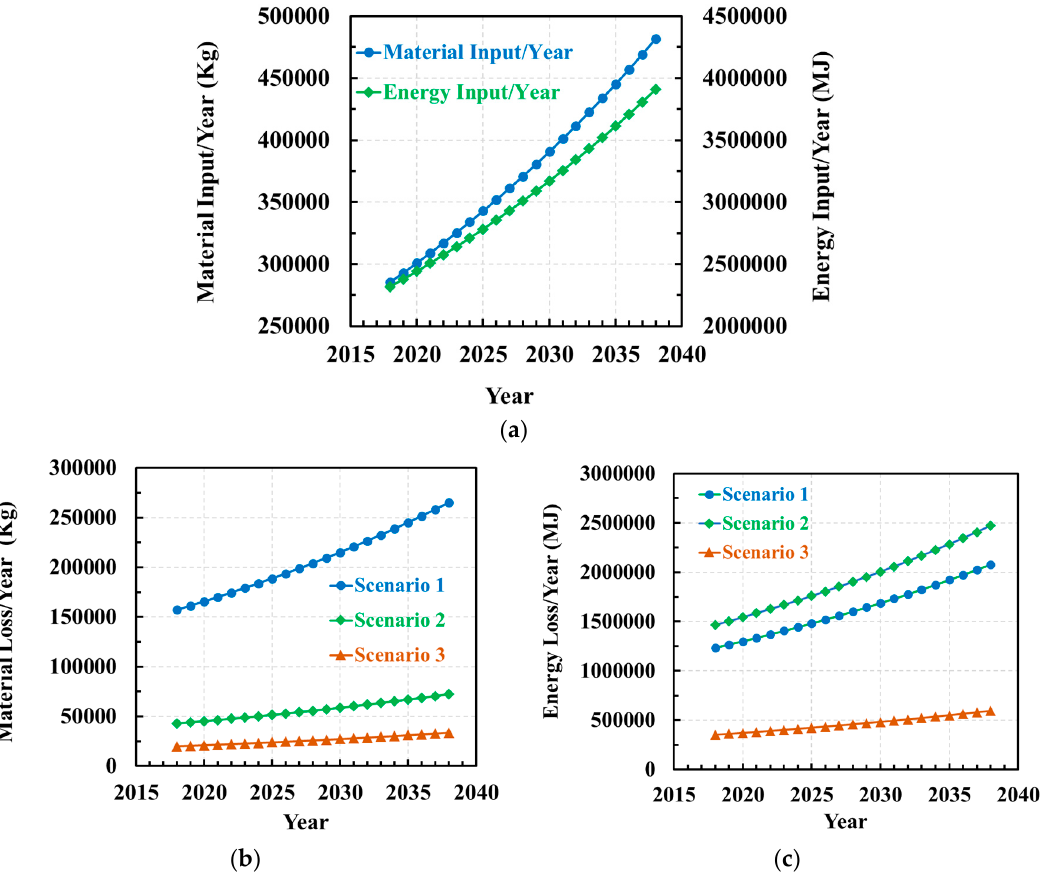
Figure 9. ( a ) Material and energy required per year to produce SX blades, ( b ) material loss for three different scenarios, and ( c ) energy loss for three different scenarios.